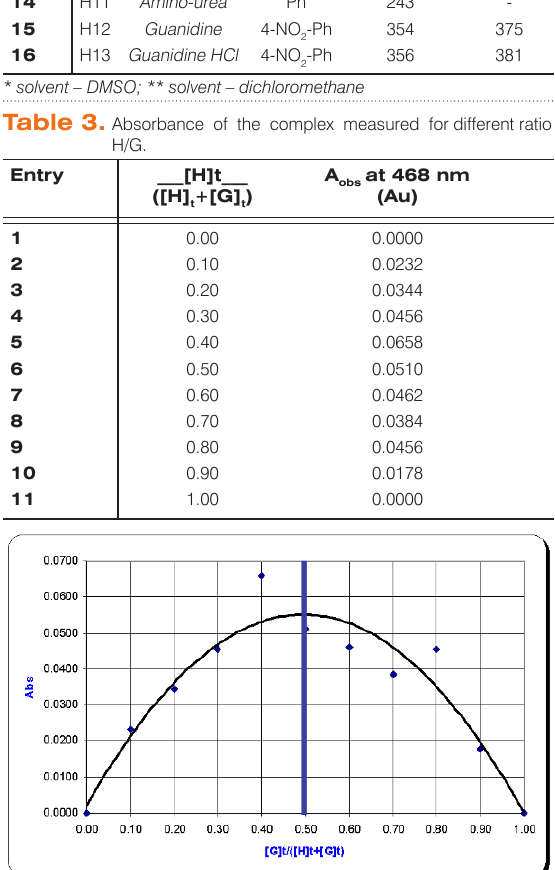
Figure 1. Modified Job’s Plot for complexation of H7 with TBAA by UV-Vis spectroscopy.